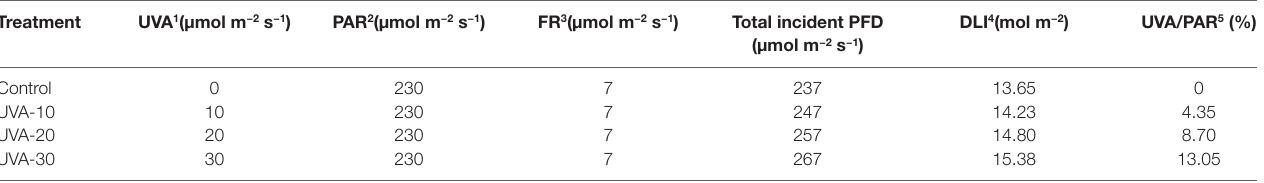
TABLe 1 | The photon flux density (PFD) at different wavebands of the four treatments.